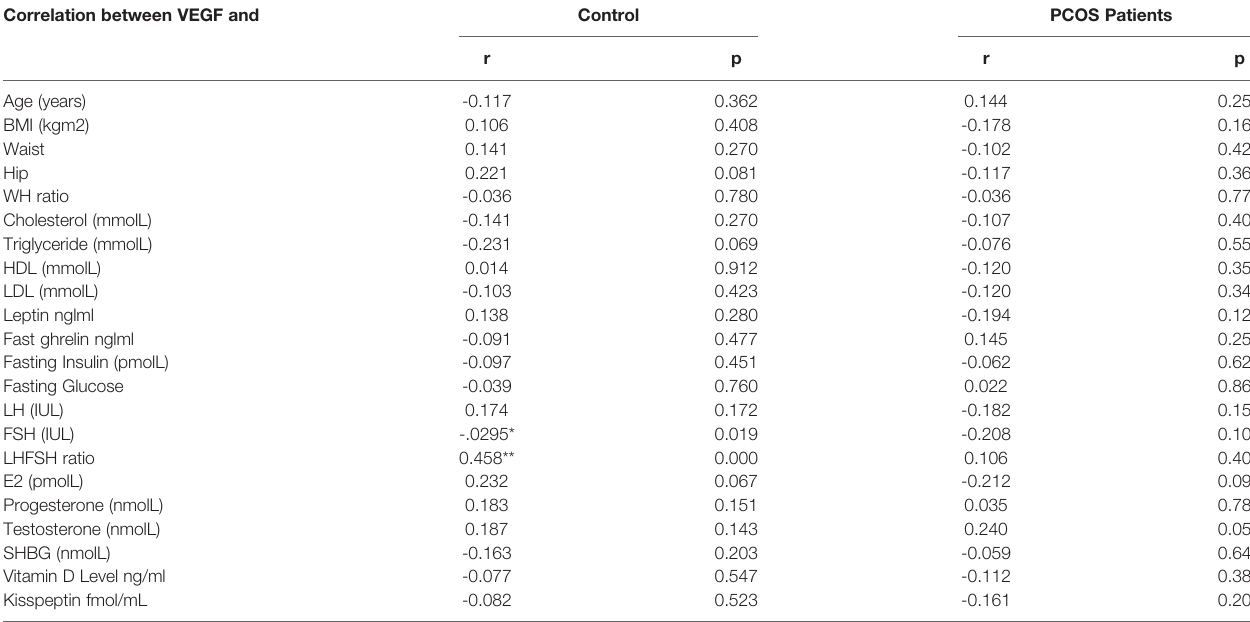
TABLE 4 | Correlations between VEGF and the studied parameters in obese PCOS and obese non-PCOS controls. Correlation between VEGF and